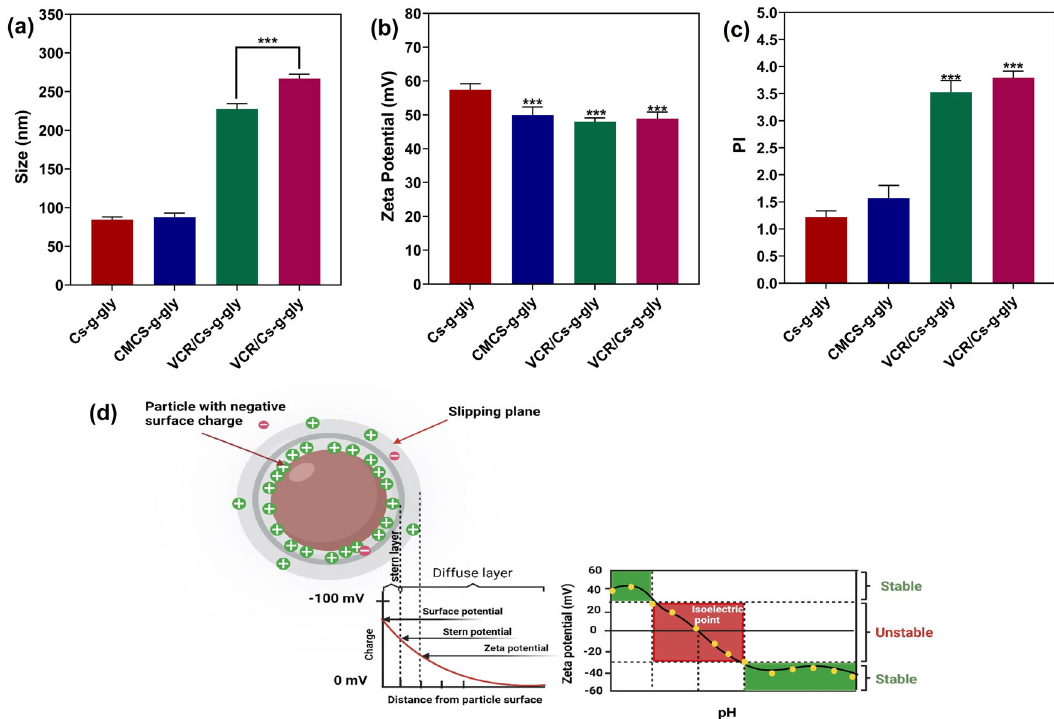
Fig. 6 Loaded and unloaded hydrogels obtained responses under the optimal conditions. a hydrogel size, ( b ) Zeta potential, and ( c ) Polydispersity, ( d ) Schematic representation of zeta potential. Data represent means ± standard deviations ( n = 3). For all charts, *** p < 0.001; ** p < 0.01; * p < 0.05.